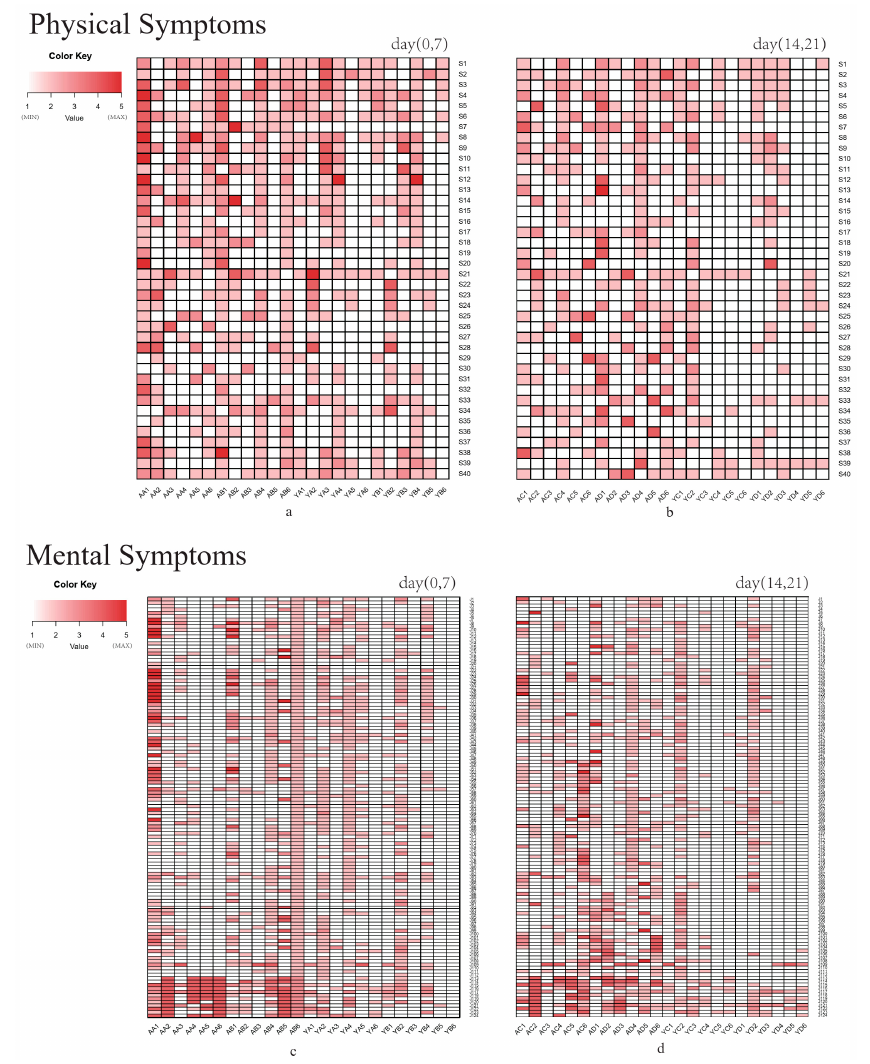
Figure 1. Heatmaps of the self-scaled scores of the physical and mental symptoms for the A and Y groups during different periods. ( a ) The heatmap of the self-scaled scores of the physical symptoms at 0 d and 7 d. ( b ) The heatmap of the self-scaled scores of the physical symptoms at 14 d and 21 d. The abscissa represents the volunteer number, the ordinate denotes the questionnaire item, and the color depth represents the item score. ( c ) The heatmap of the mental symptom self-evaluation list at 0 d and 7 d. ( d ) The heatmap of the mental symptom self-evaluation list at 14 d and 21 d. (Four follow-up surveys were conducted before and during the intervention, which were recorded as A, B, C, and D. For example, the four questionnaire numbers of volunteers A1 and Y1. Their questionnaires are AA1, AB1, AC1, and AD1; and YA1, YB1, YC1, and YD1, respectively. The other questionnaire numbers are the same as above.)